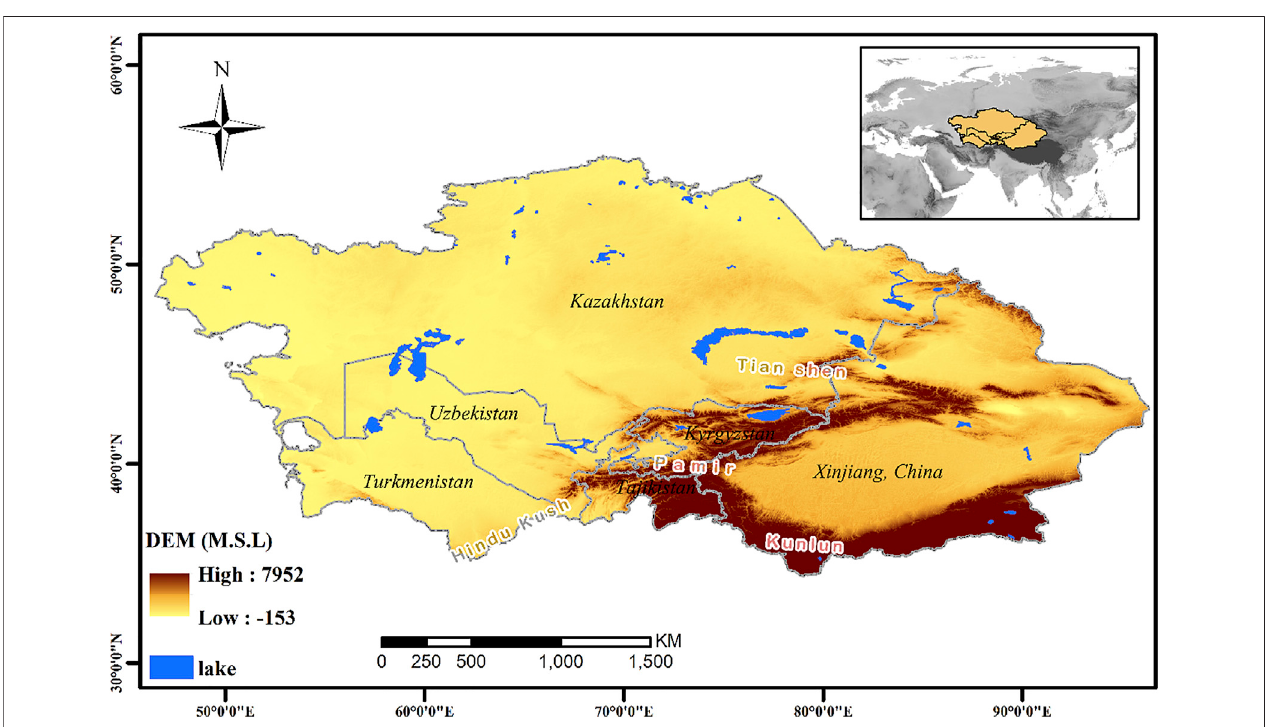
FIGURE 1 | Topographic map illustrating the geographical location and overview of Central